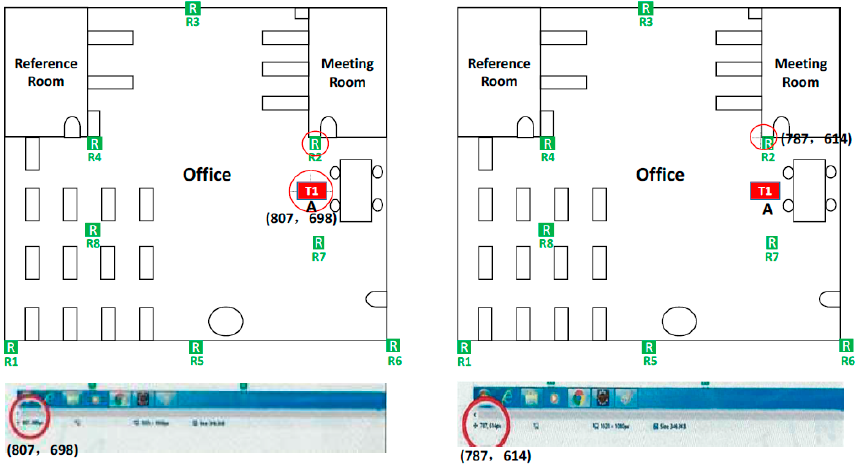
Figure 22. Coordination of A and R2.